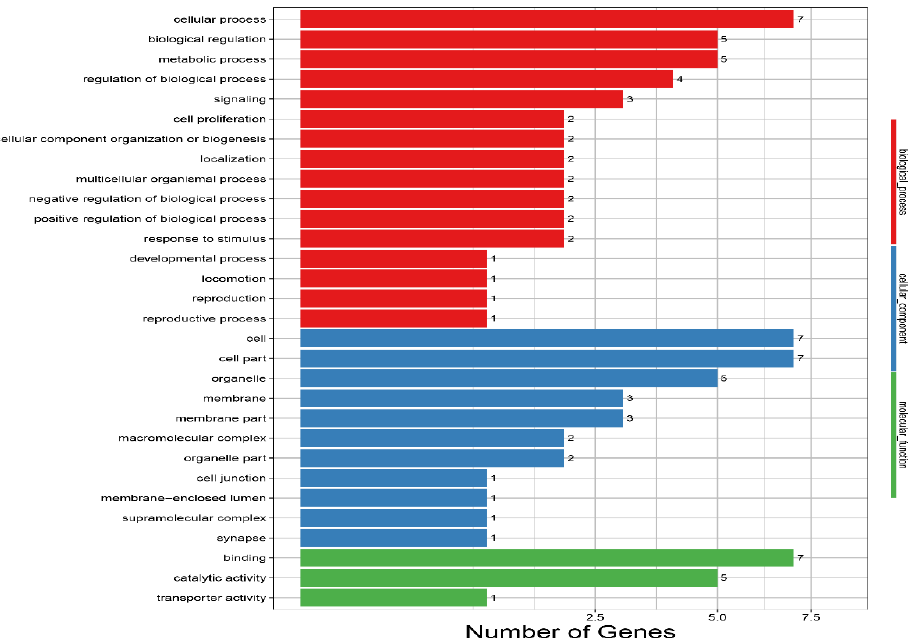
9 of 16 Figure 6. Enriched GO terms for the BG and the PLG. The vertical axis indicates GO terms, and the horizontal axis represents the number of DEGs. The numbers of enriched genes in each GO term are shown in the biological process (red color), cellular component (blue color), and molecular function (green color) areas. BG, barren environment group; PLG, environment enriched with perches and a